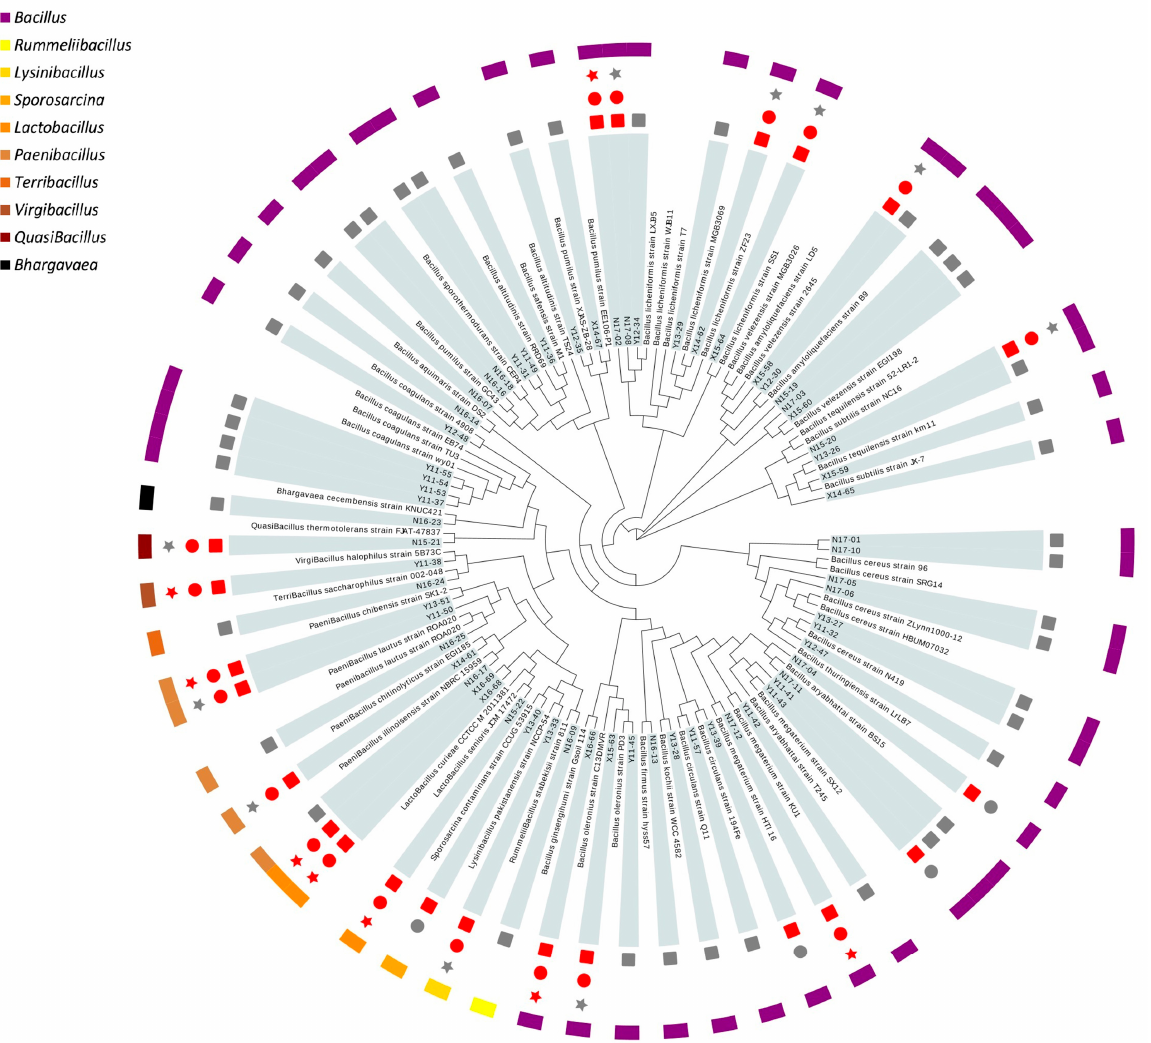
Figure 1. Phylogenetic tree analysis and primary screening of 65 strains isolated from PCR-Chachiensis. The results of hemolytic, gastrointestinal tolerance and the production of amines were respectively represented by symbols from the inside to the outside as square, circle and star. A grey symbol indicates failure and a red one indicates passing the assay.